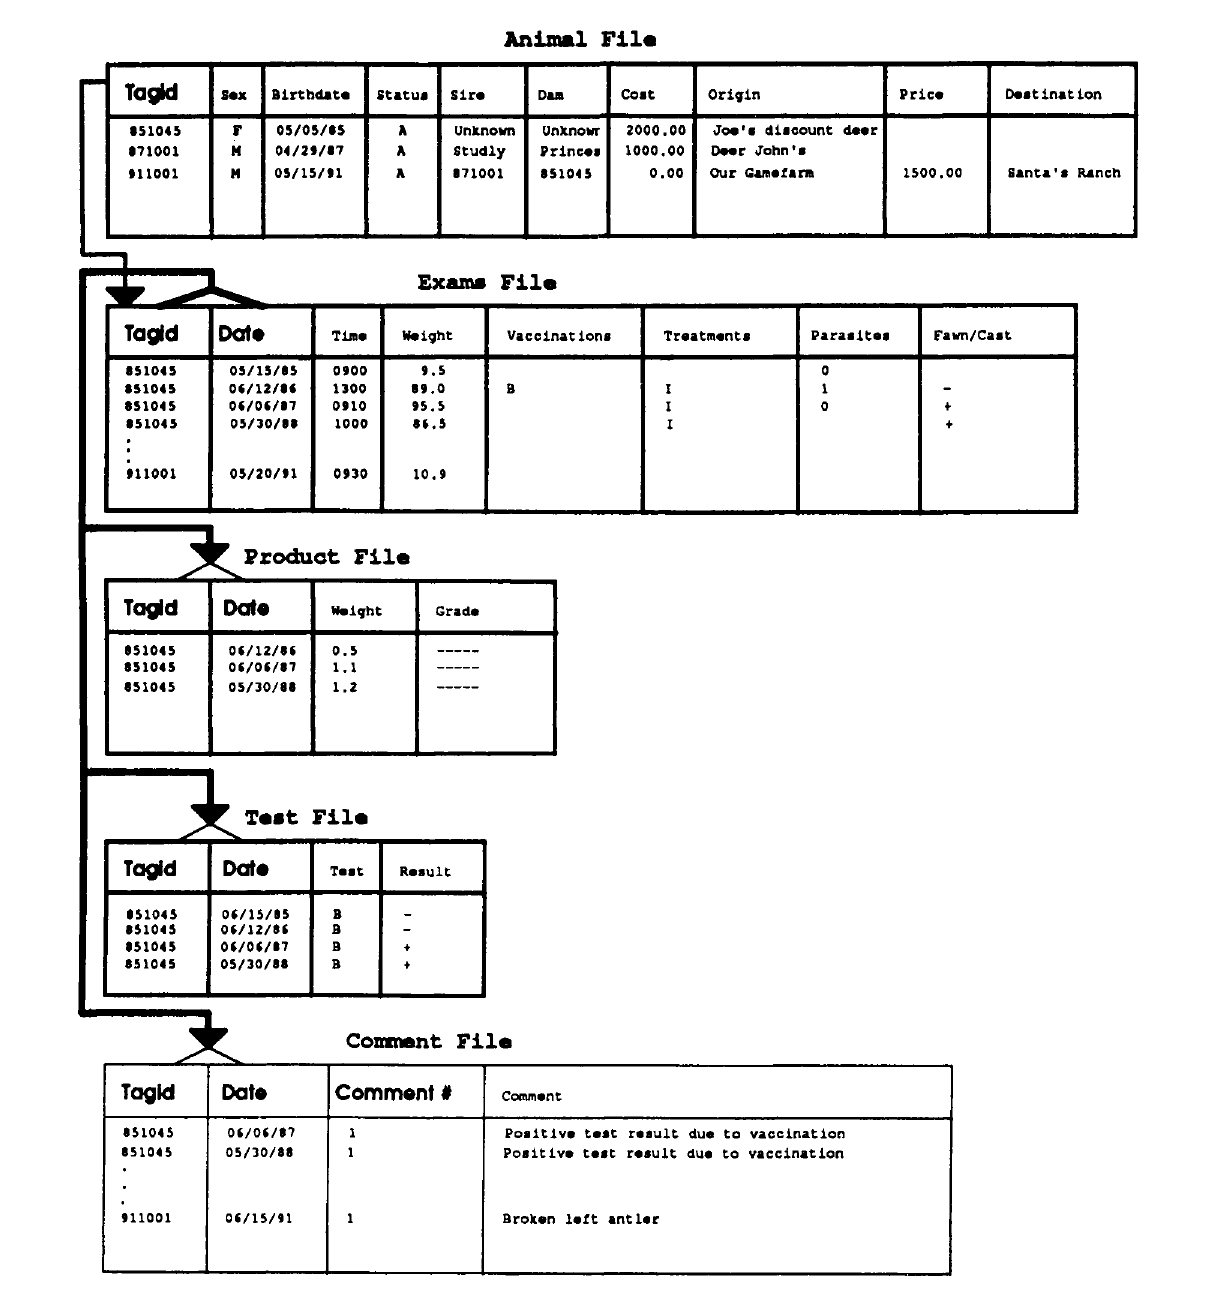
Fig. 1. Sample data files for an intensively managed reindeer herd. They include optional files: product, test, comment, and optinal fields: sire, origin, price, destination, weight, vaccinations, treatments, parasites, and fawning or castration status. Lines and arrows represent relationships between the